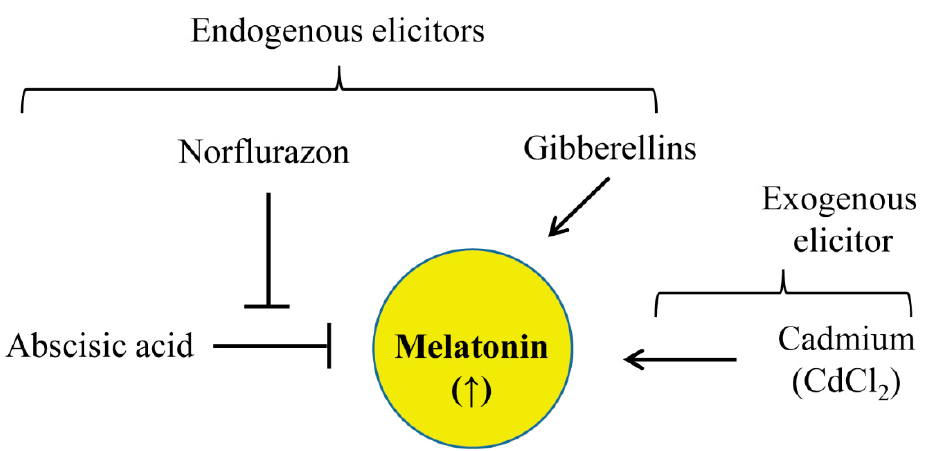
Figure 8. Proposed model of melatonin induction by endogenous hormones. GA induces melatonin production, whereas ABA inhibits melatonin production. Norflurazon, an ABA biosynthetic inhib- itor, functions as a potent elicitor of melatonin production. functions as a potent elicitor of melatonin